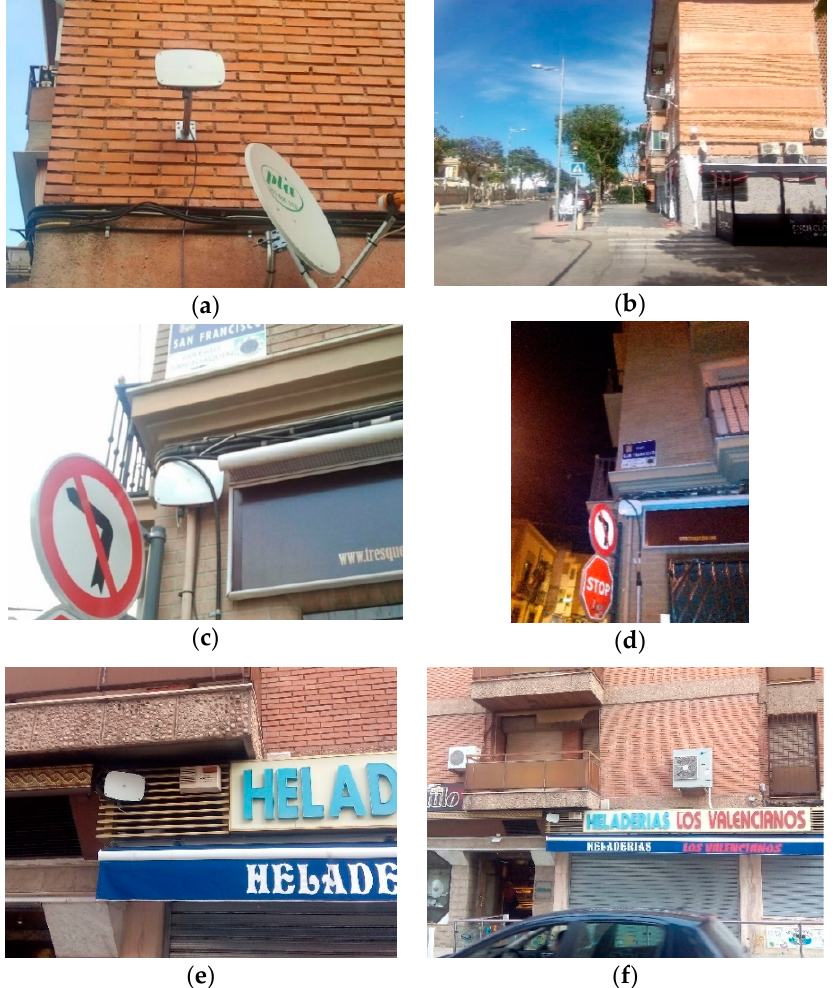
Figure 10. The sensor nodes deployed in the city. ( a , b ) Id 8: Ubeda Street; ( c , d ) Id 5: San Francisco Square; ( e , f ) Id 1: Andalucia Avenue.